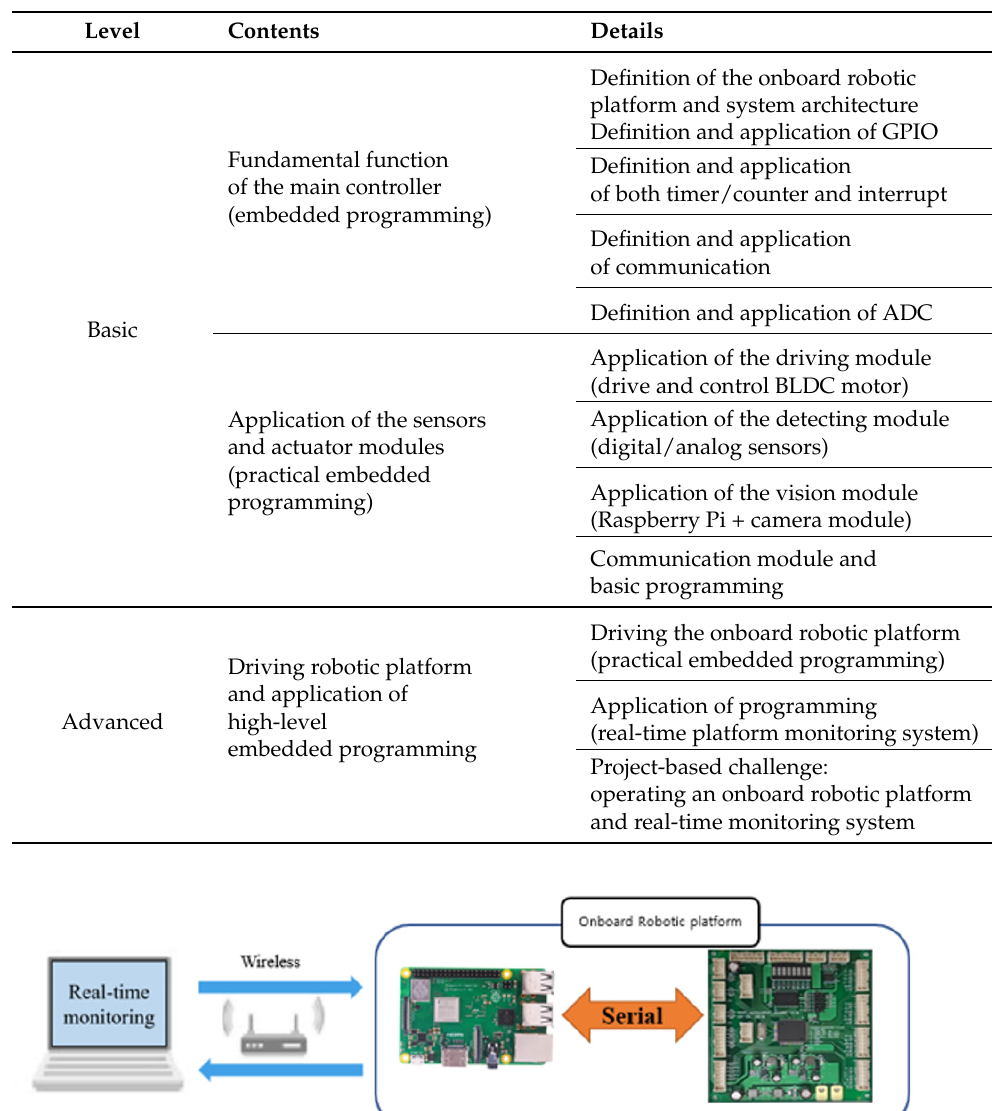
Table 2. Detailed curriculum.